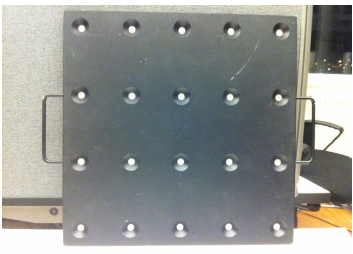
Figure 1: The plate used for calibration, with 4 × 5 circular retro- reflective markers arranged in a regular grid pattern.